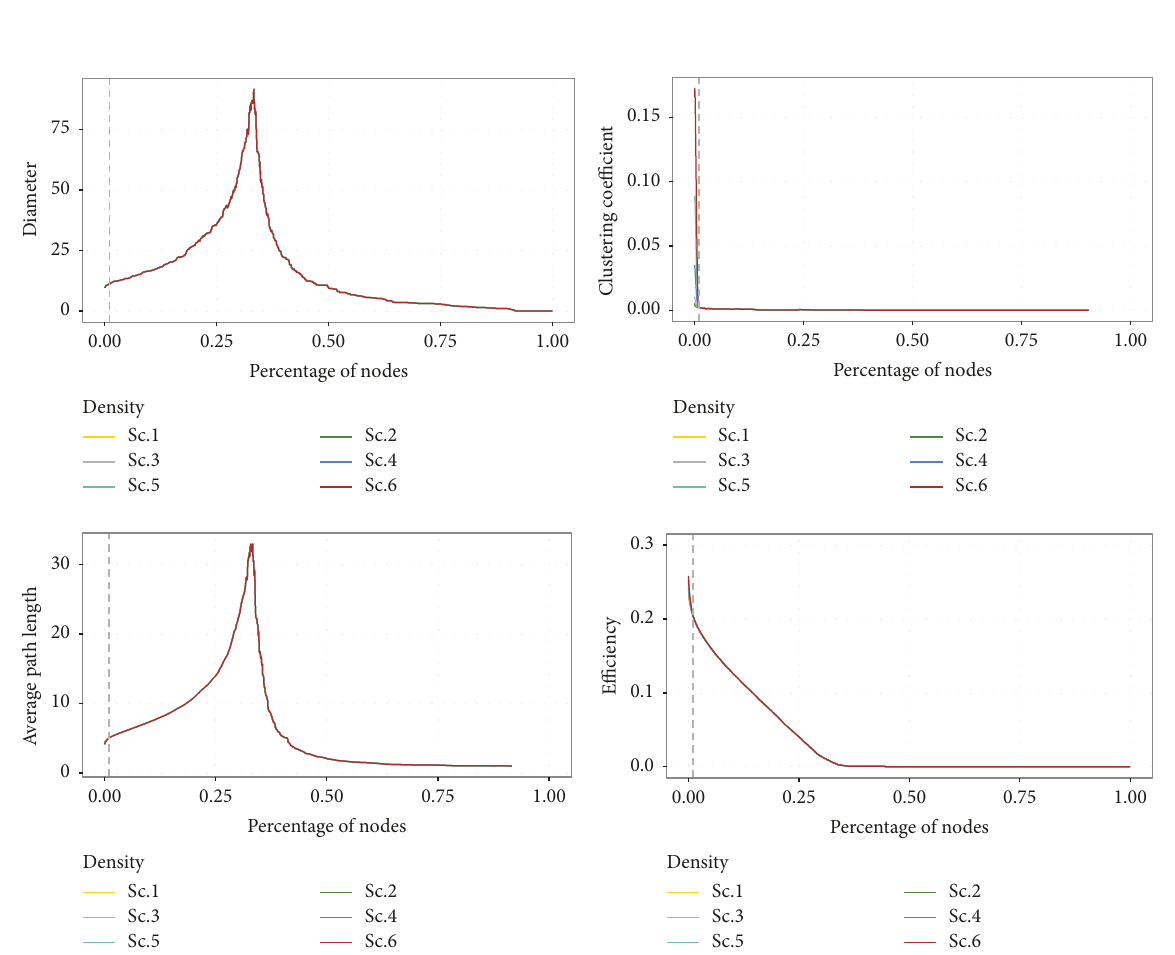
Figure 3: Resilience for simultaneous attack simulations with progressive manipulation of the number of links in the network core. The dashed line is placed in correspondence with the rich-club size. All results are averaged over 10